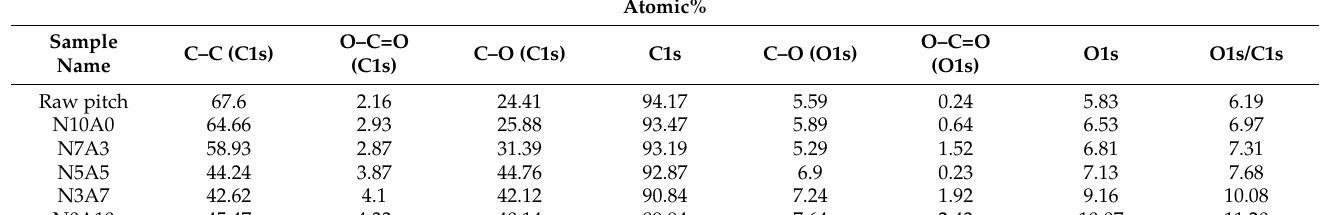
Table 4. Atomic% of C1s and O1s from X-ray photoelectric spectroscopy (XPS).